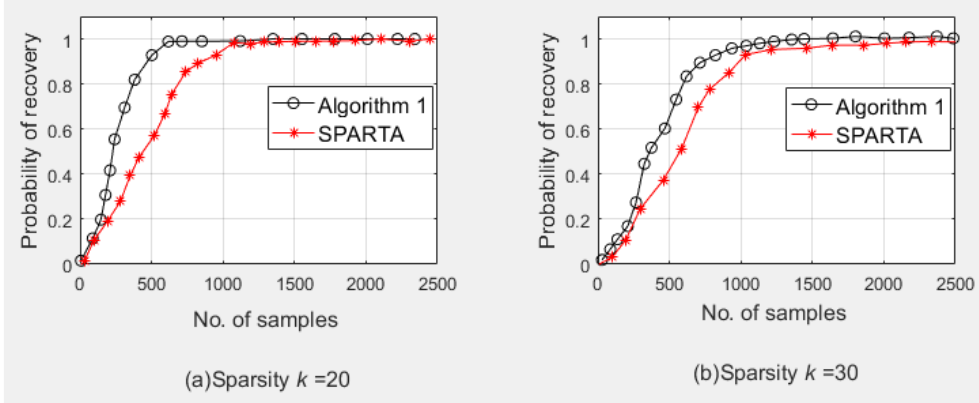
Figure 6. Phase shift diagram, signal length n = 2000: ( a ) Sparsity k = 20; ( b ) Sparsity k = 30.